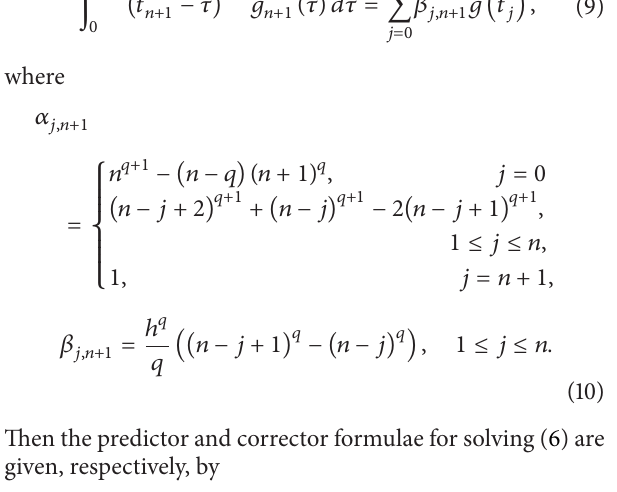
Figure 1: The arch-like PDF curve for random variable 𝑢